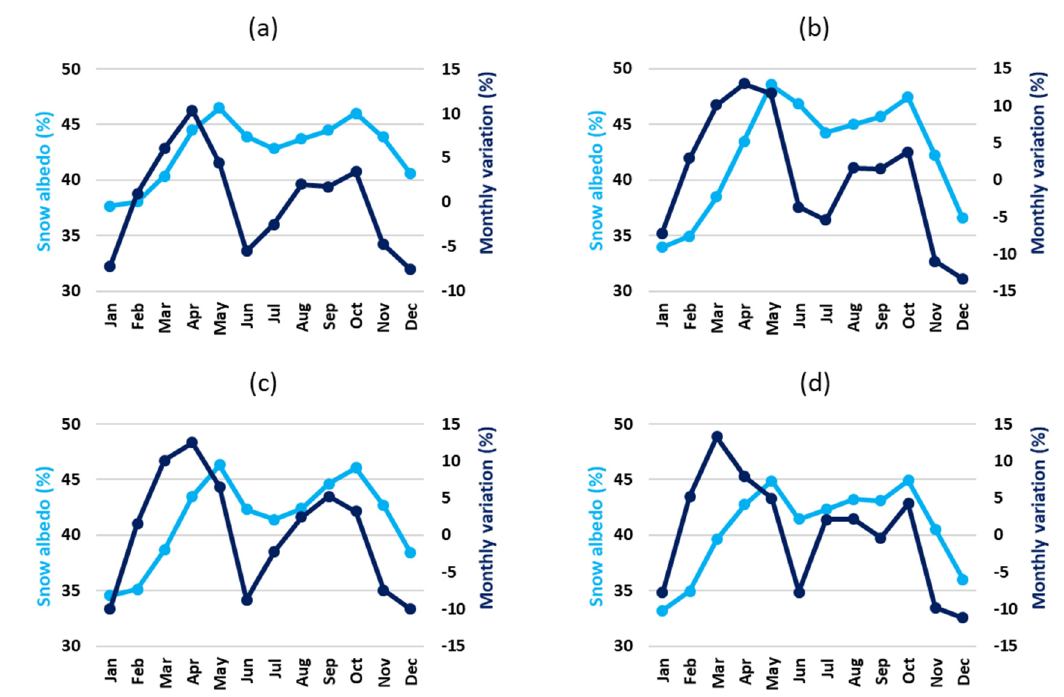
Figure 5. Monthly mean snow albedo (light blue line) and its monthly variation (dark blue line) in: ( a ) whole area, ( b ) northern area, ( c ) southwestern area, and ( d ) southeast area. (For interpretation of the references to color in this figure legend, the reader is referred to the web version of this article.) .